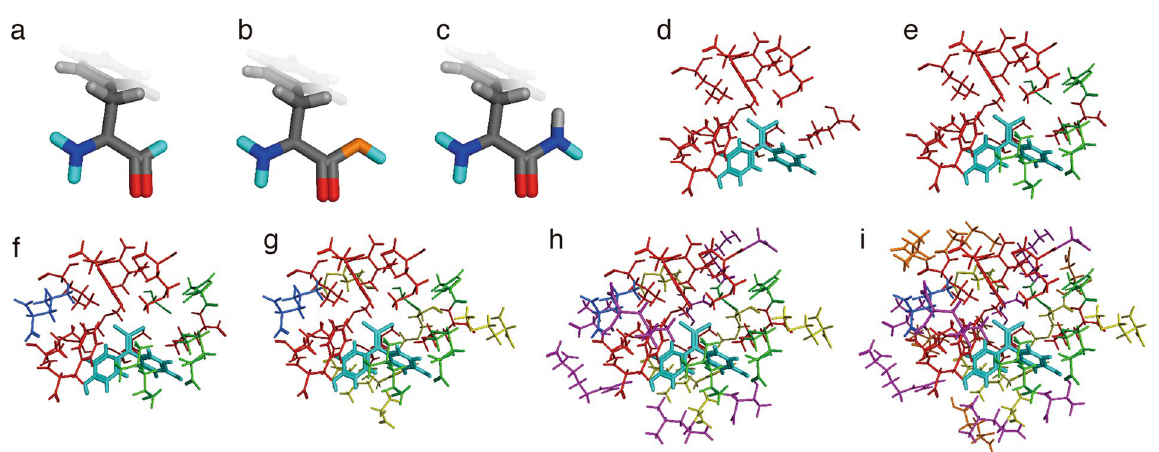
Figure 5. Clipped coordinates and evaluation using three compensating methods or ab initio calculation. Terminal atoms were generated by compensating with ( a ) typically utilized protonation methods involving the in-filling of hydrogen atoms (Case 1), ( b ) reconstructing each clipped amino acid residue as an individual amino acid (Case 2), and c expanding the selected region to include the nitrogen atom at the i − 1 position and protonate conventionally (Case 3), respectively. Clipped atoms from the deposited coordinates of the human ER α crystal structure (PDB ID: 3UUC) were from ranges of ( d ) 4 Å, ( e ) 5 Å, ( f ) 6 Å, ( g ) 7 Å, ( h ) 8 Å, and ( i ) 9